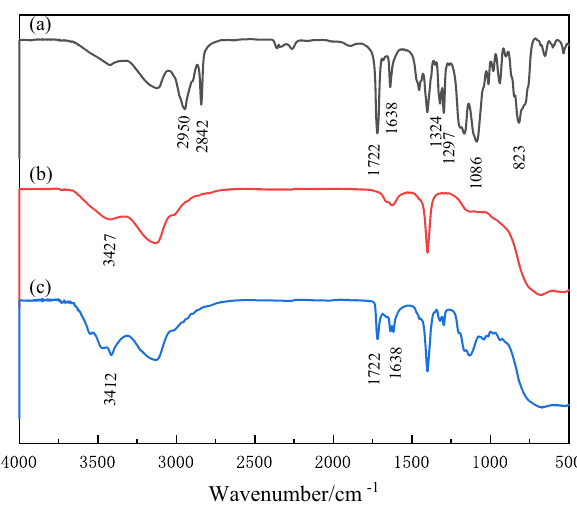
Figure 5: FT - IR diagram of nano - TiO 2 before and after modi fi